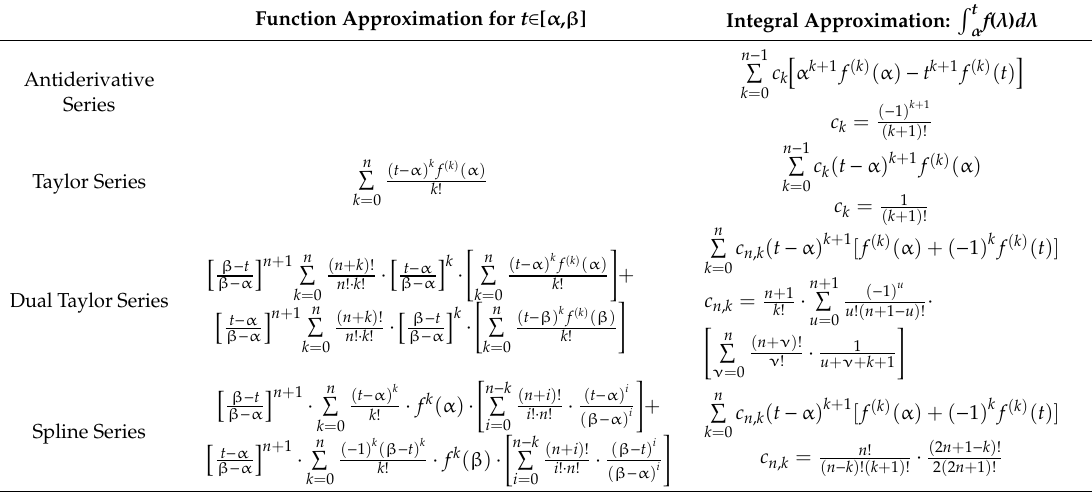
Table 2. Summary of function and integral approximations.